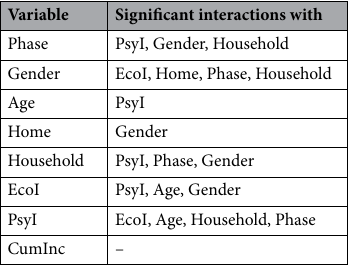
Table 3. Significant interactions identified by the logistic regression model.